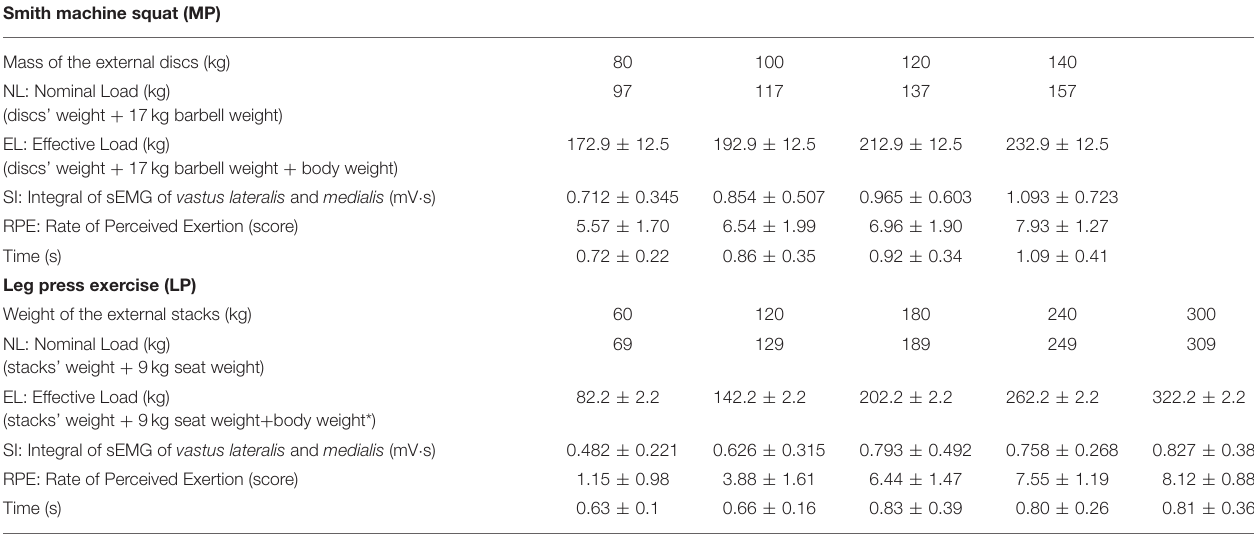
TABLE 1 | Data relative to Smith machine squat (MP) and leg press exercise (LP) trials (Mean ± Standard Deviation). Smith machine squat